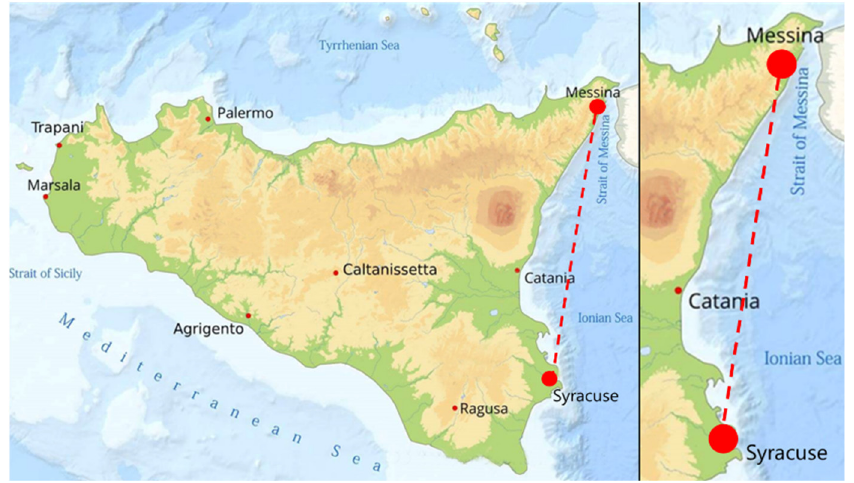
Figure 1. Study area between Messina and Syracuse.